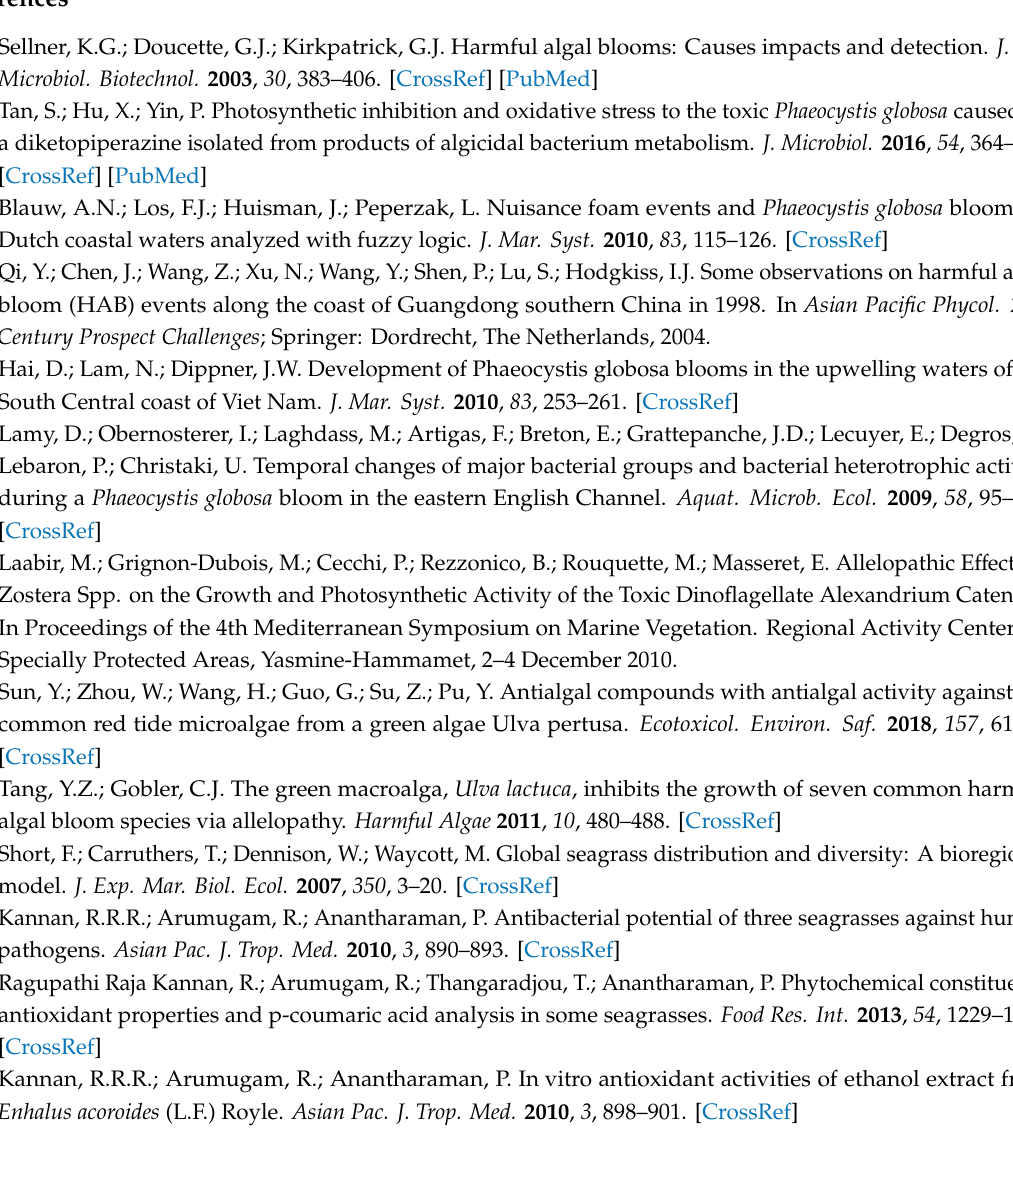
Figure S9: Mass spectrogram of chrysoeriol-7-O-glucuronide at 3.66 min negative ionization mode at low energy channels, Figure S10: Mass spectrogram of 6-hydroxy-1,3-divinyldihydropyrimidine-2,4,5(3H)-trione at 3.95 min (A)positiveionizationmodeatlowenergychannels; (B)postiveionizationmodeathighenergychannels, FigureS11: Mass spectrogram of luteolin at 4.07 min (A) positive ionization mode at low energy channels; (B) negative ionization mode at low energy channels; (C) positive ionization mode at high energy channels; (D) negative ionization mode at high energy channels, Figure S12: Mass spectrogram of apigenin at 4.48 min (A) positive ionization mode at low energy channels; (B) negative ionization mode at low energy channels; (C) positive ionization mode at high energy channels; (D) negative ionization mode at high energy channels, Figure S13: Mass spectrogram of chrysoeriol at 5.18 min (A) negative ionization mode at low energy channels; (B) negative ionization mode at high energy channels, Figure S14: Mass spectrogram of (9E,12Z)-octadeca-9,12-dienamide at 9.36 min (A) positive ionization mode at low energy channels; (B) positive ionization mode at low energy channels, Figure S15: Mass spectrogram of palmitamide at 10.04 min (A) positive ionization mode at low energy channels; (B) positive ionization mode at low energy